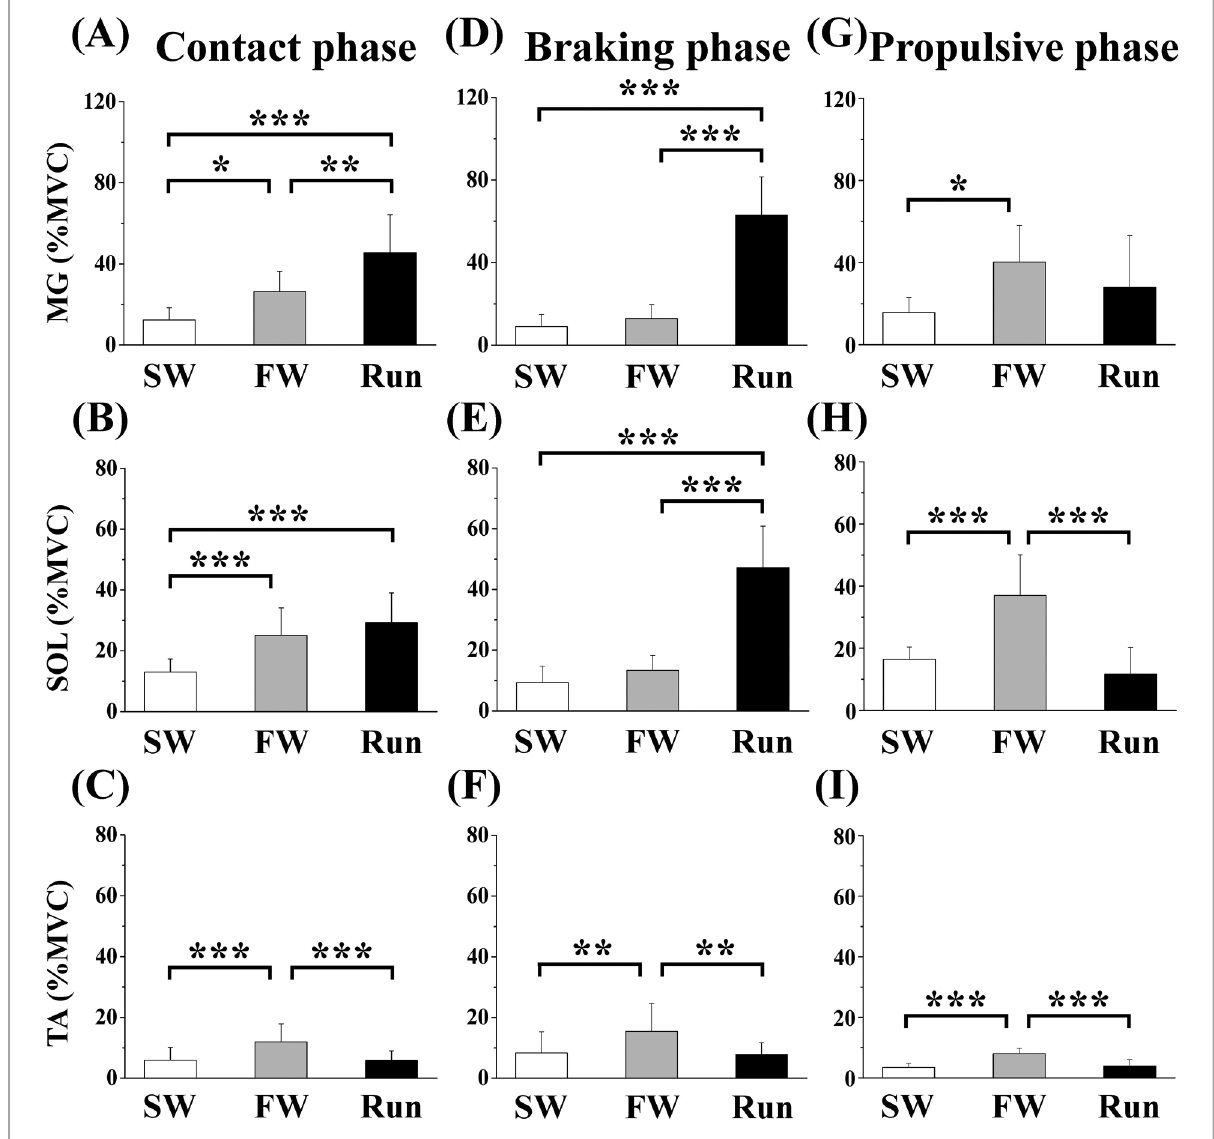
FIGURE 6 Averaged surface electromyography (aEMG) of lower leg muscles during the contact ( A — C ), braking ( D — F ) and propulsive ( G — I ) phases. Values are means±SD. Signi fi cant difference between trials (* p <0.05, ** p <0.01, *** p <0.001). SW; Slow walk trial. FW; Fast walk trial. Run; Run trial. MG; Gastrocnemius medialis, SOL; Soleus, TA; Tibialis